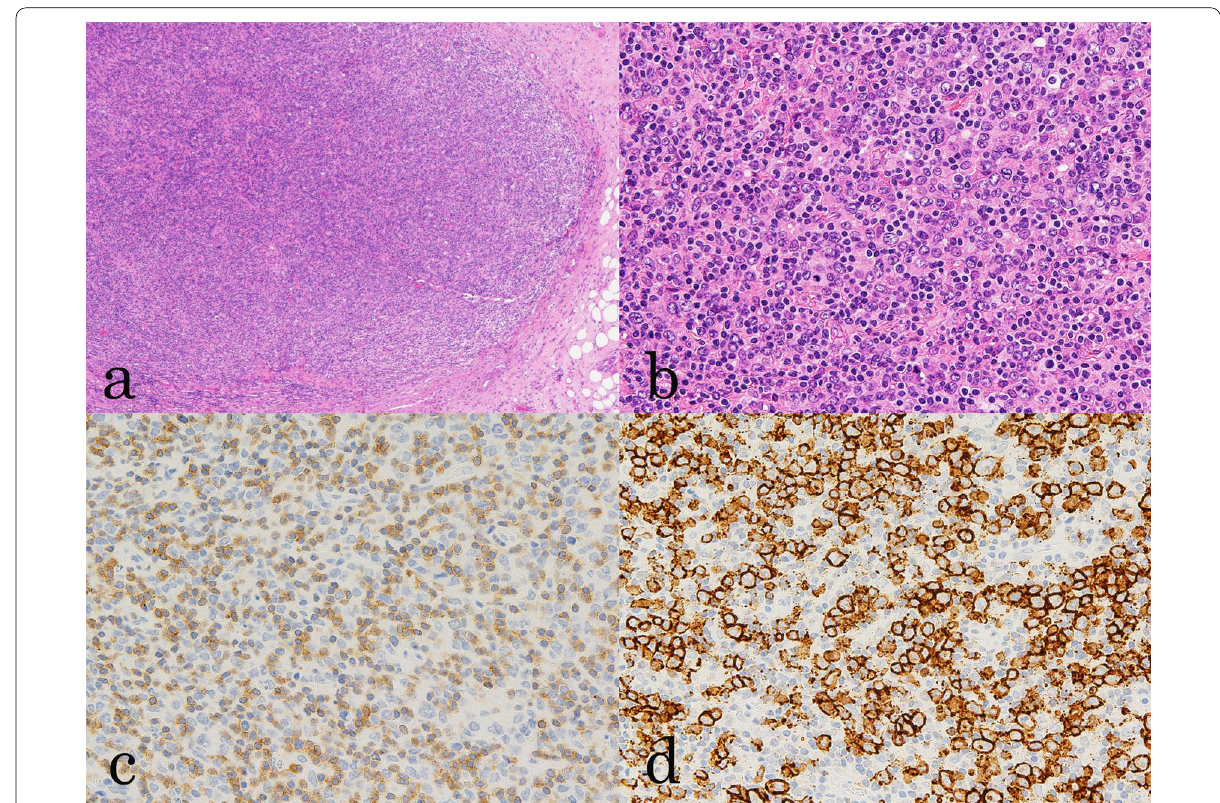
Fig. 2 Histopathological examination of the inguinal lymph nodes. HE staining revealed the loss of the native lymph node architecture and diffused proliferation of large lymphocytes against a background of numerous small lymphocytes and histiocytes ( a magnification). Immunostaining for c CD3; d CD20. The large lymphoid cells are selectively positive for CD20, and numerous CD3-positive small T-lymphocytes are observed in background, supporting the diagnosis of diffuse large B-cell lymphoma (